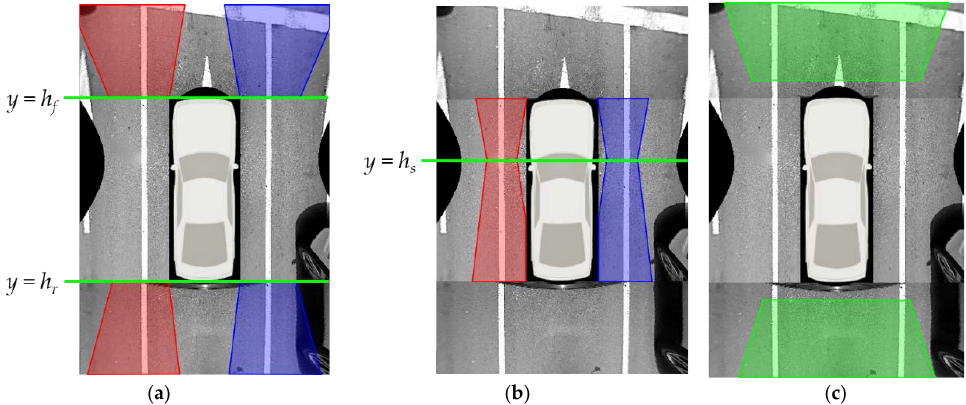
Figure 4. Precalculated position range of lane markings. ( a ) Position ranges of left and right lanes in images of the front and rear cameras; ( b ) Position ranges of left and right lanes in images of the left and right cameras; ( c ) Position ranges of stop lines in images of the front and rear cameras. Red, blue, and green regions indicate the position ranges of left lanes, right lanes, and stop lines, respectively.